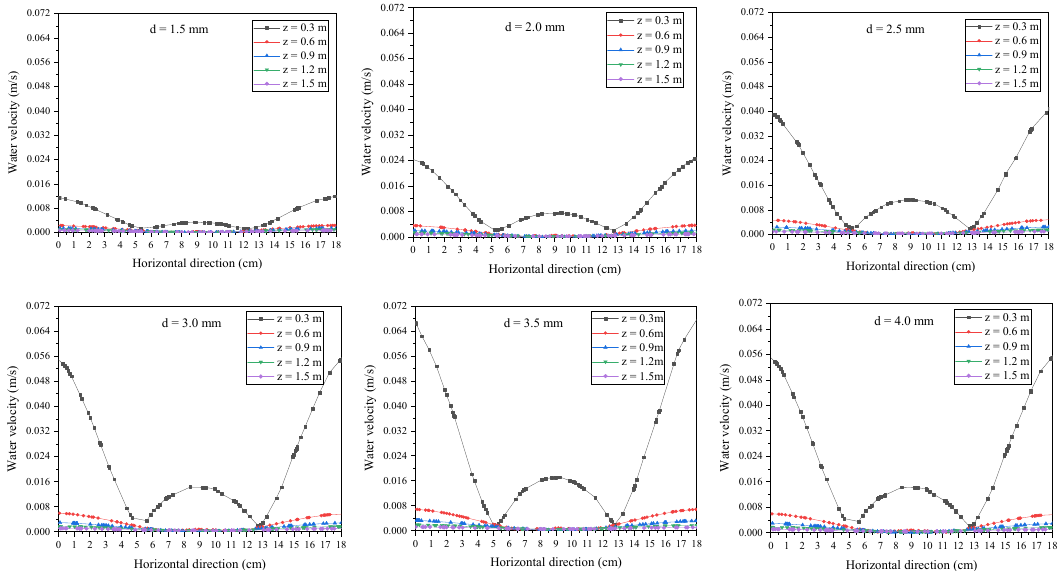
Figure 6. Cloud map of air velocity variations along the horizontal direction at different orifice di-